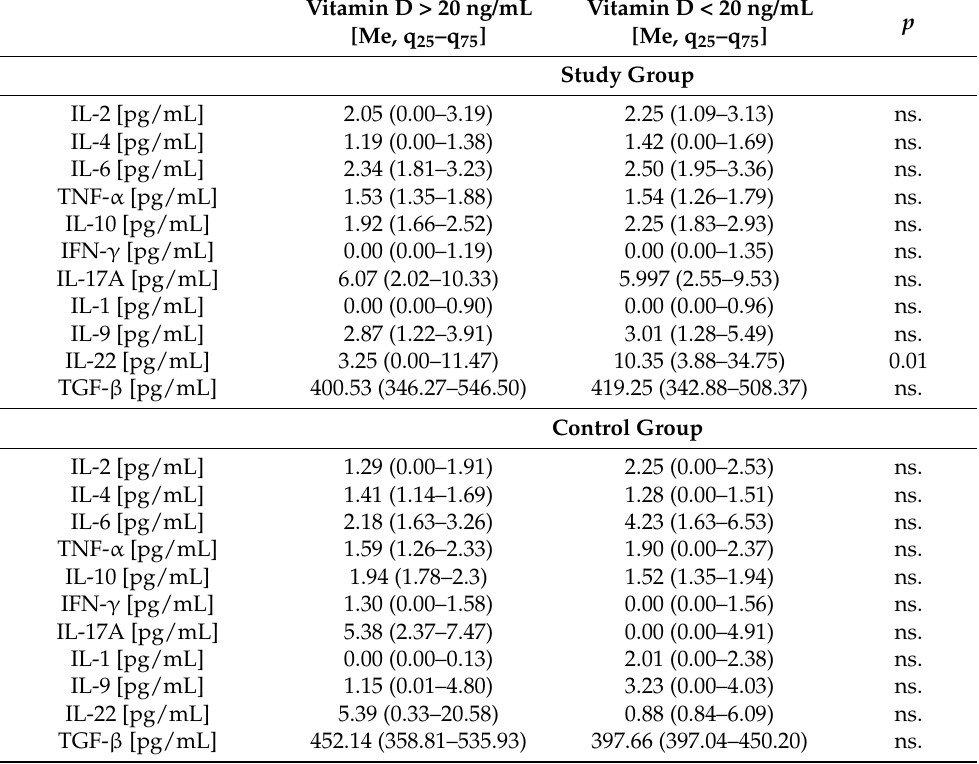
Table 4. Effect of vitamin D on blood